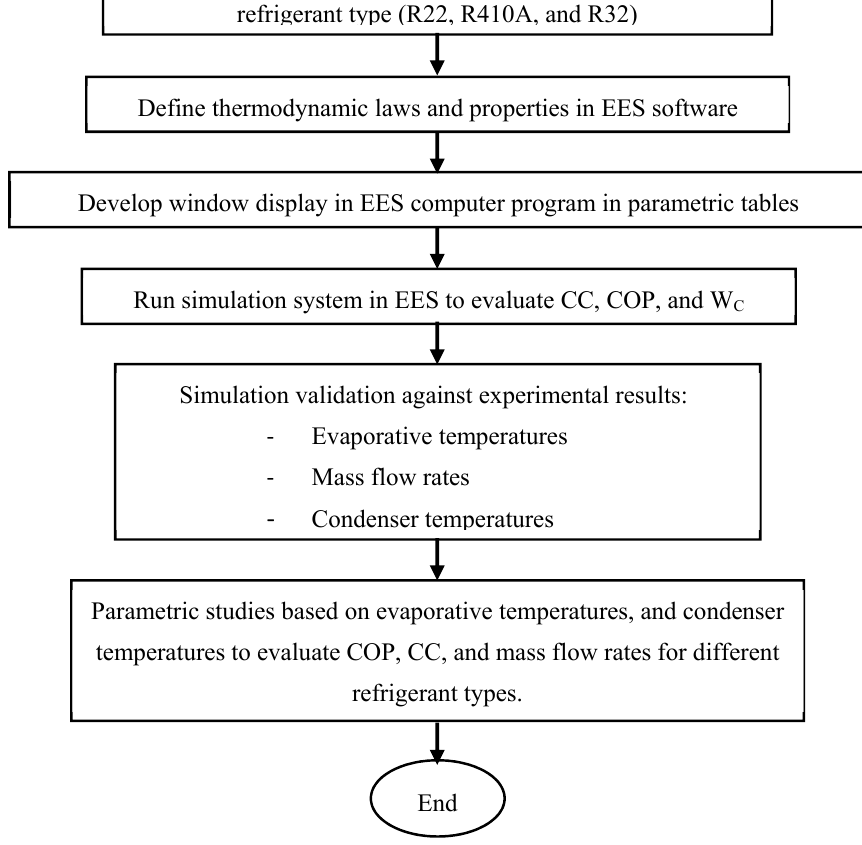
Figure 3. Flow chart of an EES system modeling.